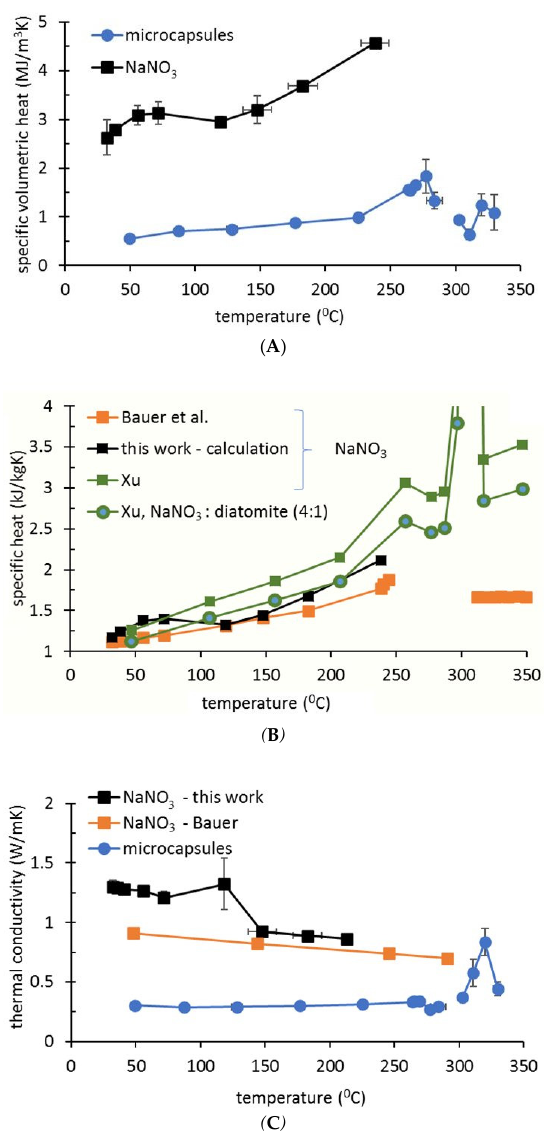
Figure 4. Thermal properties of NaNO 3 –ZnO microcapsules in comparison with pure NaNO 3 . Hot Disk determinations (own data) of volumetric specific heat ( A ) and thermal conductivity ( C ), in comparison with other works. ( B ) Specific heat of pure sodium nitrate and of a composite mixture of NaNO 3 : diatomite (same weight ratio as microcapsules). External data are from Bauer et al. 2013 [21] and Xu et al. 2017 [4].